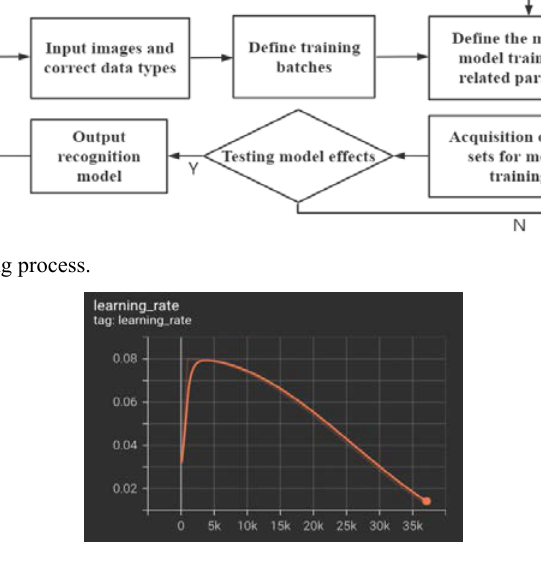
Fig. 5. SSD network model adaptive learning rate.